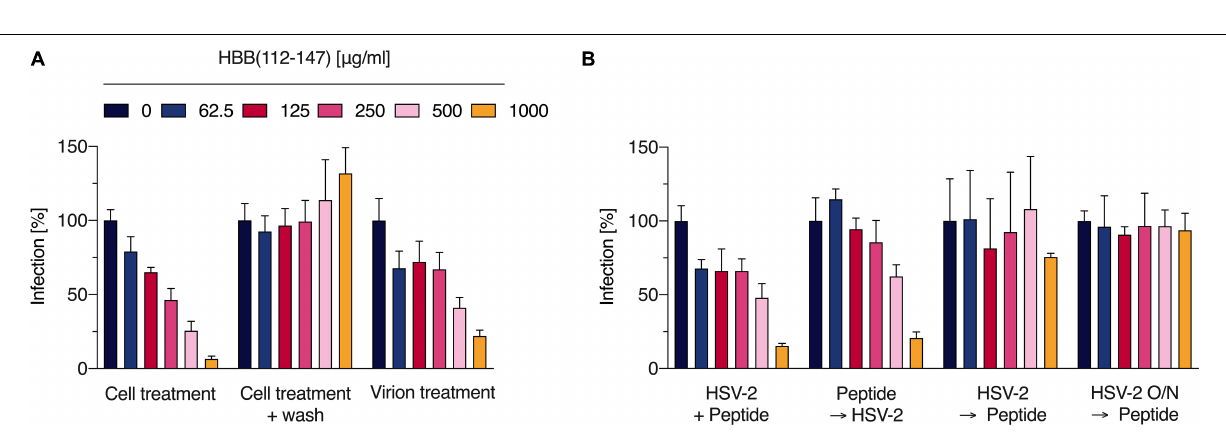
Frontiers in Microbiology |